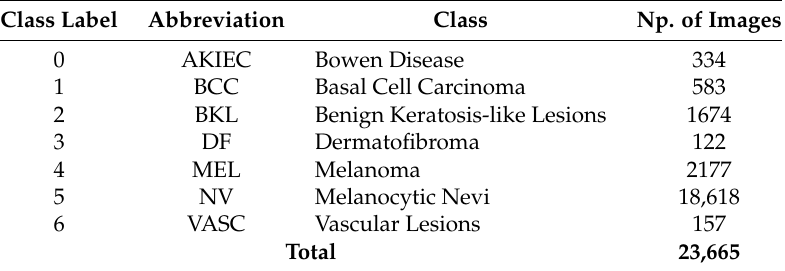
Table 2. Overview of ISIC Archive Dataset and Distribution of